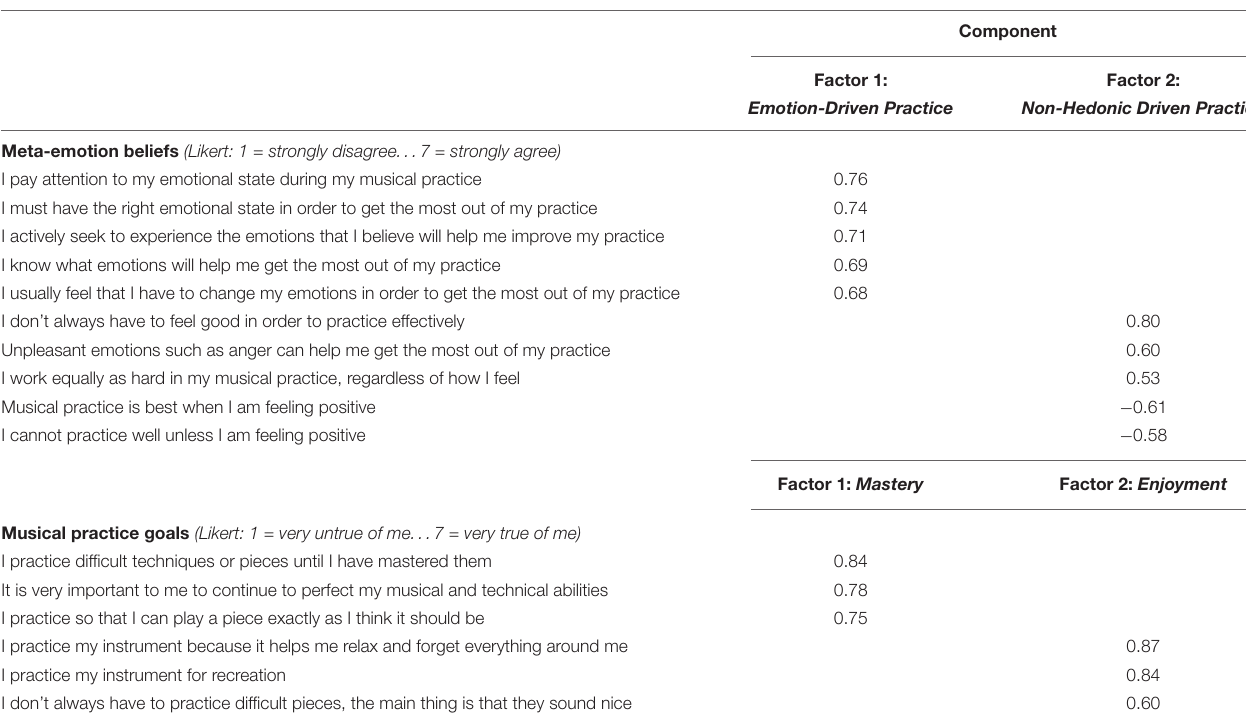
TABLE 3 | PCA (with oblique rotation) of meta-emotion beliefs and musical practice goals.